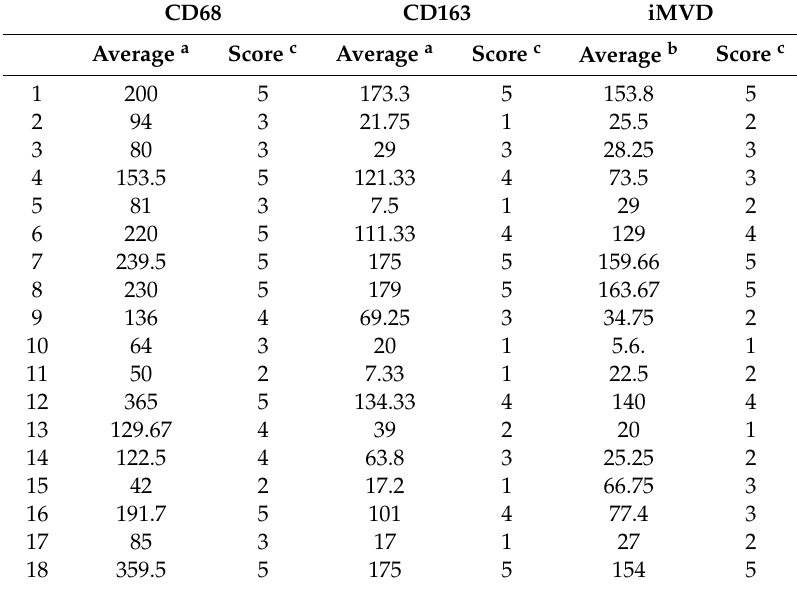
Table 2. CD68, CD163 positive cells, and intratumor microvessel density in CHS